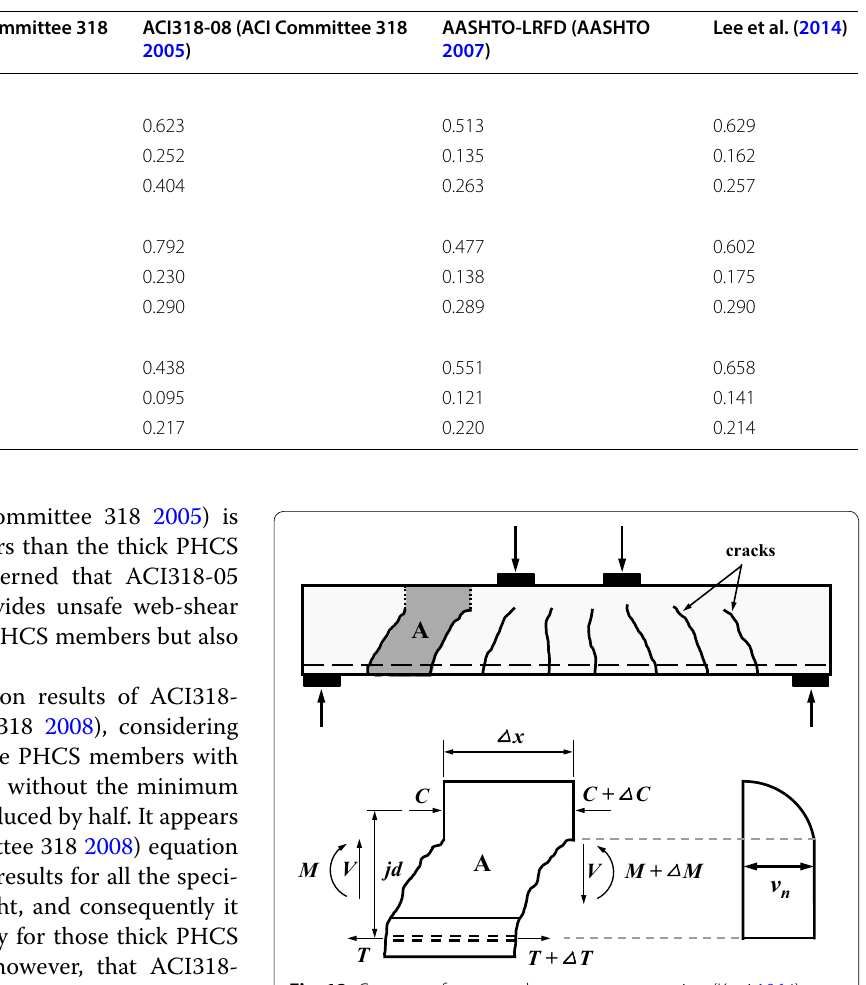
Fig. 12 Concept of average shear stress assumption (Kani